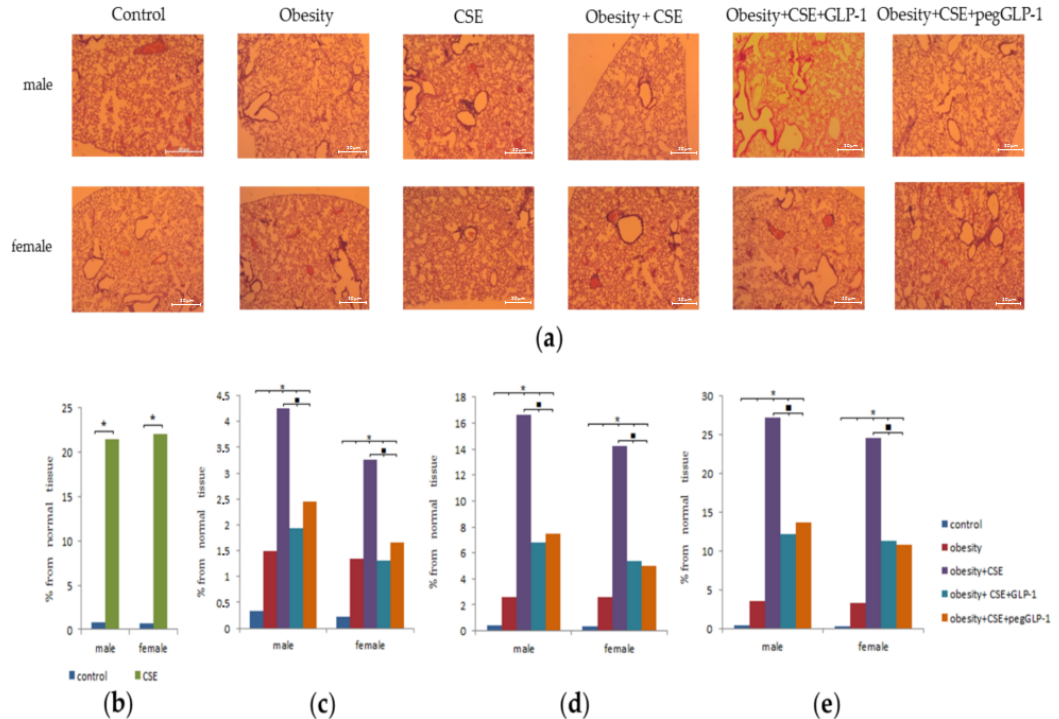
Figure 4. Morphological study of lung obtained from male and female C57BL / 6 mice ( n = 6): ( a ) Photomicrographs of left lung sections (lower pulmonary field) (on p189). Tissues were stained with hematoxylin-eosin; ( b ) The area of emphysema-expanded lung tissue (lower pulmonary field) of mice from all groups (on p148); ( c ) The area of emphysema-expanded lung tissue (upper pulmonary field) of mice from all groups (on p); ( d ) The area of emphysema-expanded lung tissue (middle pulmonary field) of mice from all groups (on p189); ( e ) The area of emphysema-expanded lung tissue (lower middle pulmonary field) of mice from all groups (on the p189). Groups: control—a control group from intact mice, obesity—mice with metabolic disorders (obesity and hyperglycemia), CSE—mice with lungs emphysema, obesity + CSE—mice with metabolic disorders (obesity and hyperglycemia) and lungs emphysema, obesity + CSE + GLP-1–mice with metabolic disorders (obesity and hyperglycemia) and lungs emphysema treated with GLP-1, obesity + CSE + pegGLP-1—mice with metabolic disorders (obesity and hyperglycemia) and lungs emphysema treated with pegGLP-1. * p < 0.05 significance of di ff erence compared with control group, (cid:4) —significance of di ff erence compared with the obesity + CSE group ( p <